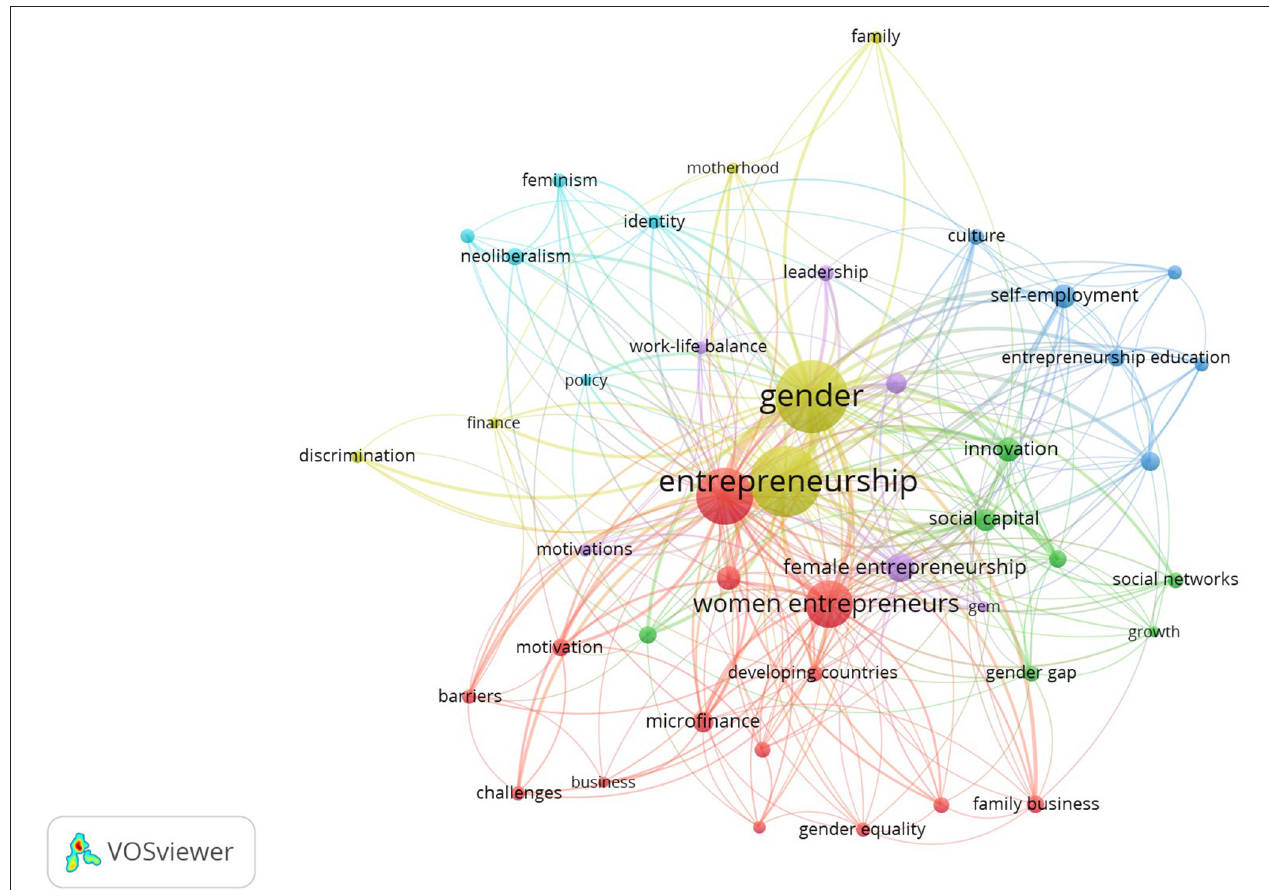
FIGURE 7 | A minimum of 10 co-occurrence for author’s